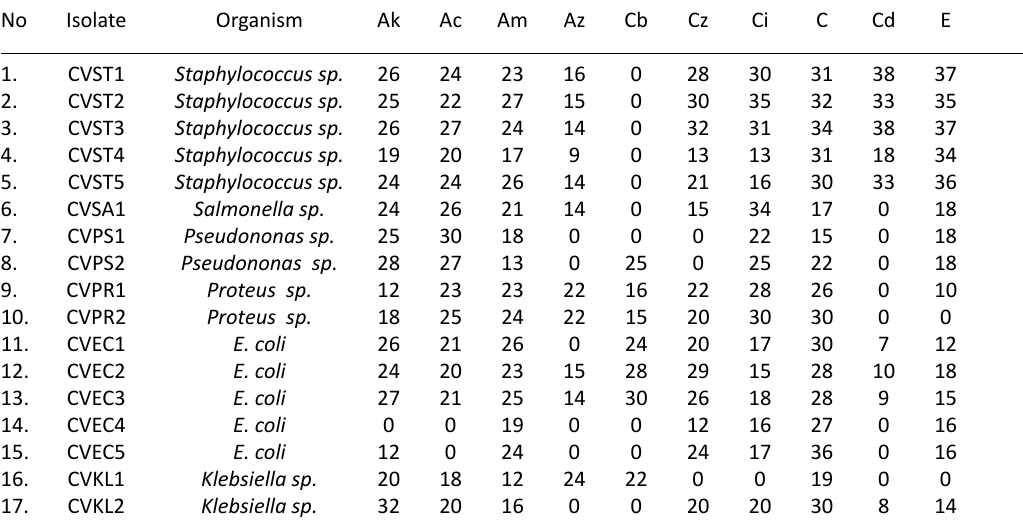
Table 5. Antibiotic Resistance of Isolates No Isolate